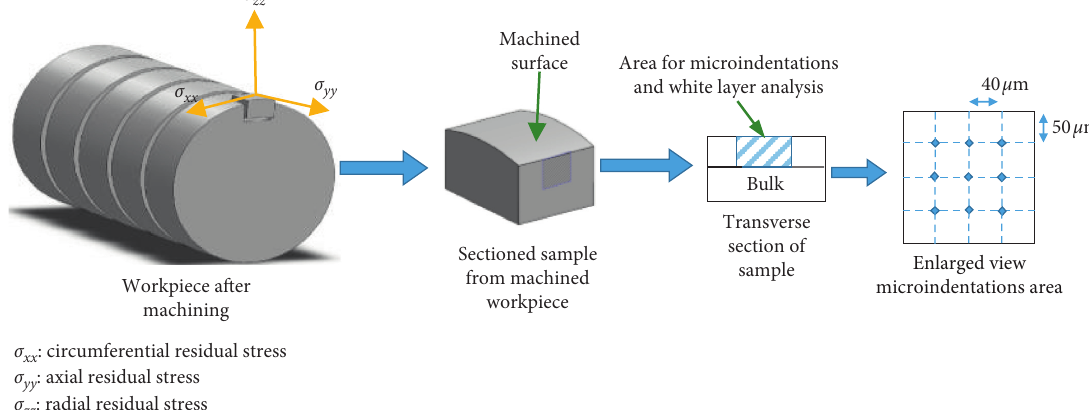
Figure 4: Sample preparation for measurement of microhardness, white layer, and residual stress.